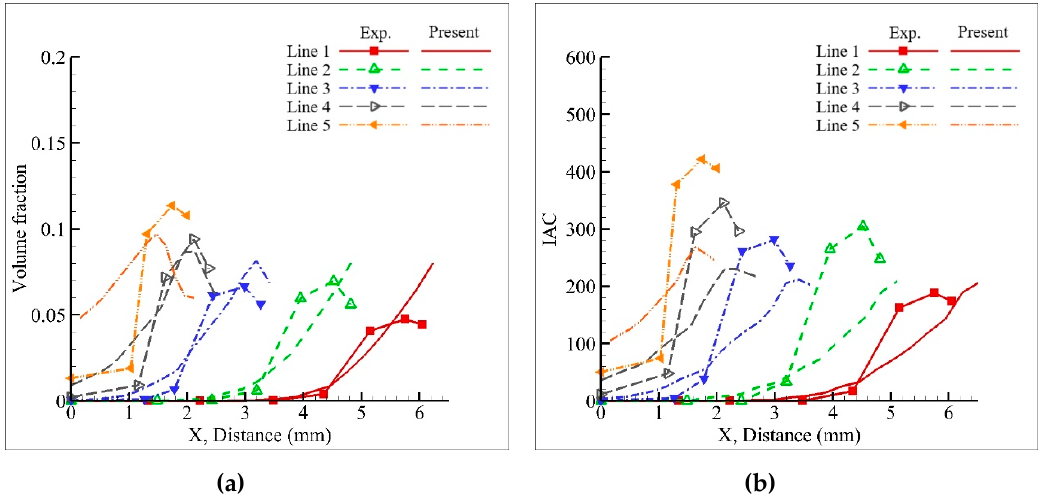
Figure 7. Case 1 numerical results of Lines 1–5 compared with experiment results: ( a ) volume fraction and ( b ) interfacial area concentration.